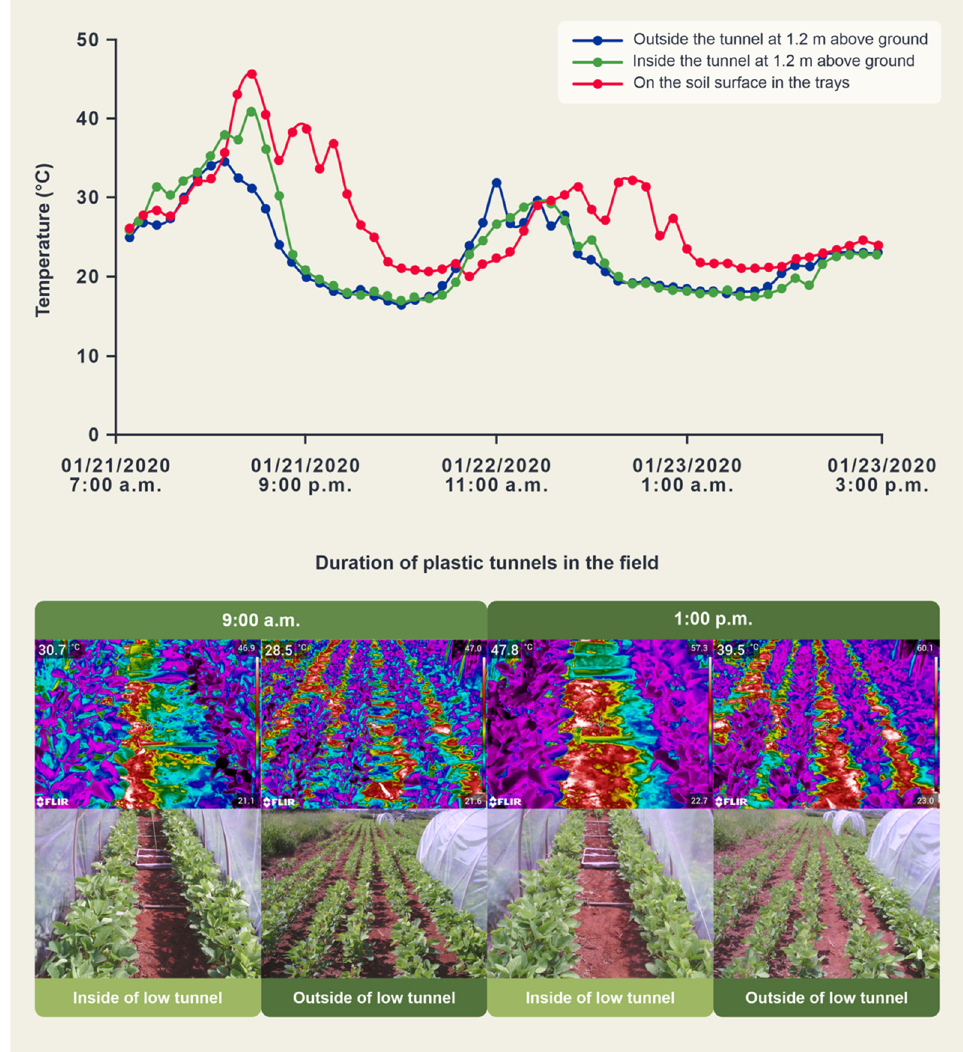
Figure 1. Temperatures and thermal images inside and outside the low tunnels.